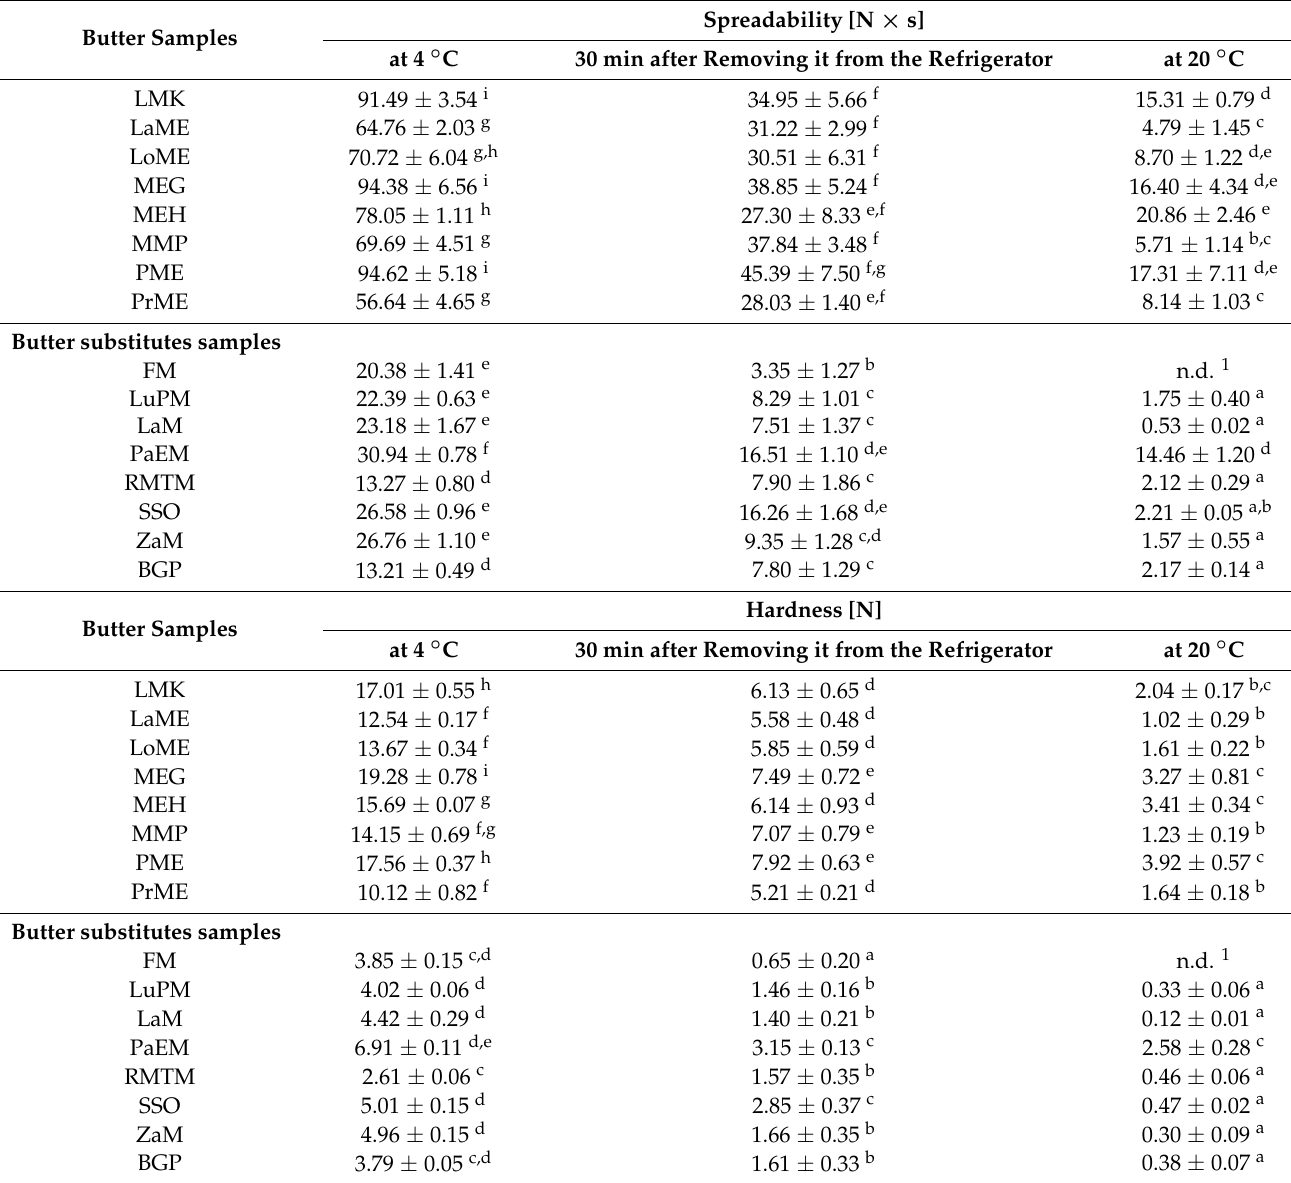
Table 4. Texture characteristics of butter and butter